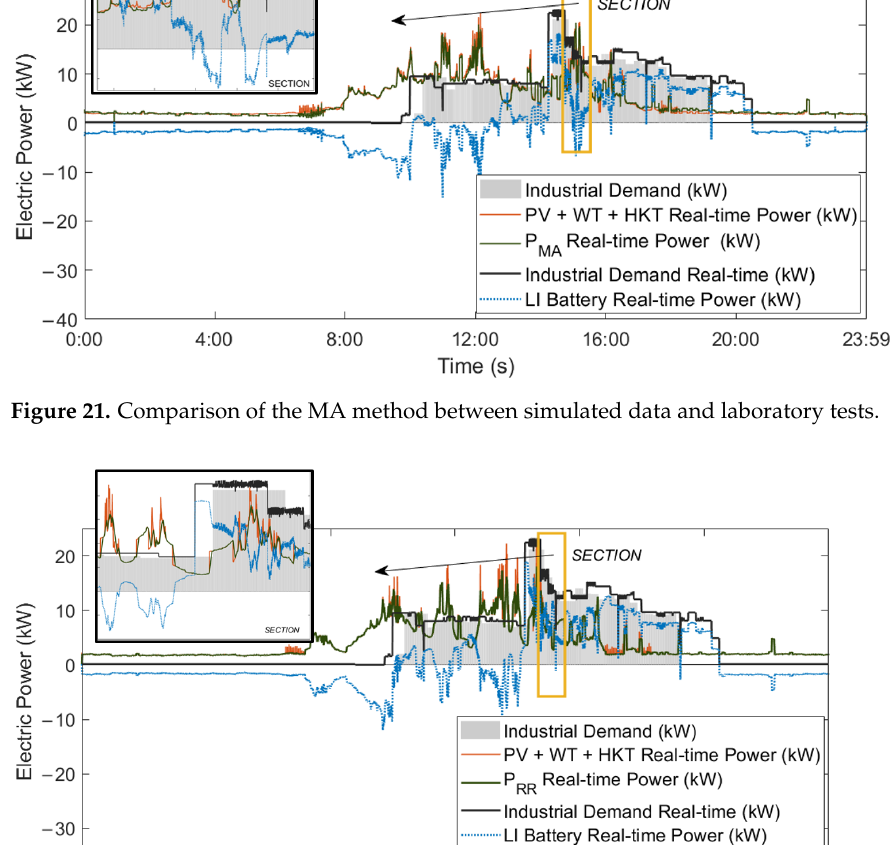
Figure 21. Comparison of the MA method between simulated data and laboratory tests.